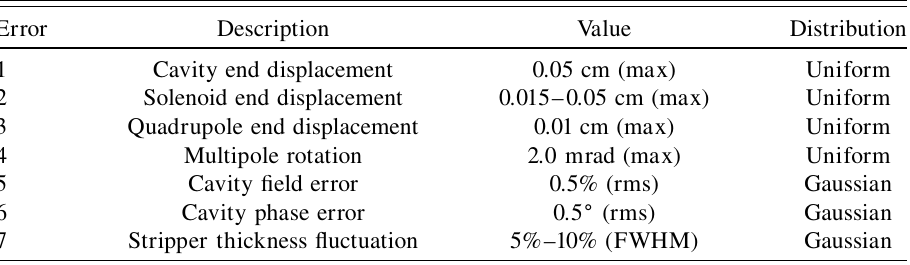
TABLE I. Different sources of error and their typical values. For solenoid displacement, the error depends on the length of the solenoid. Smaller errors are applied to shorter solenoids.